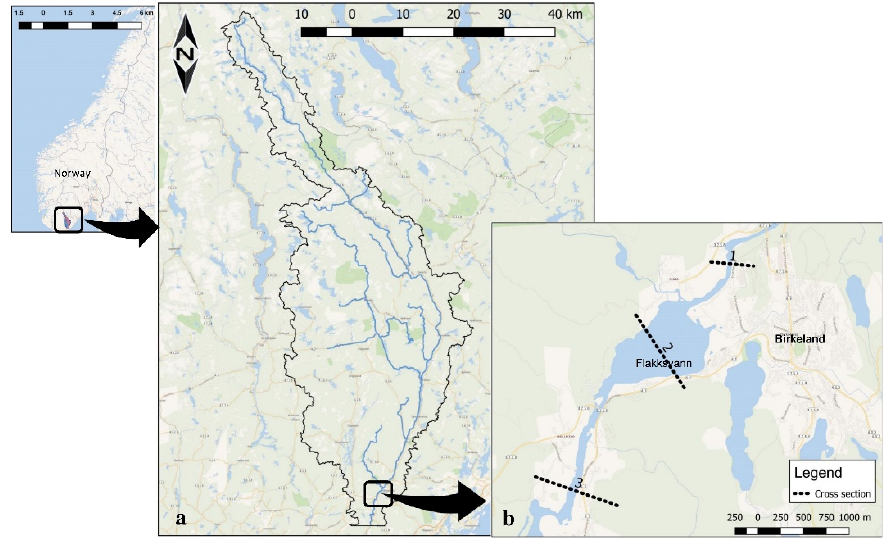
Figure 1. ( a ) Map of Tovdal river’s catchment area. ( b ) The case study area with specified cross